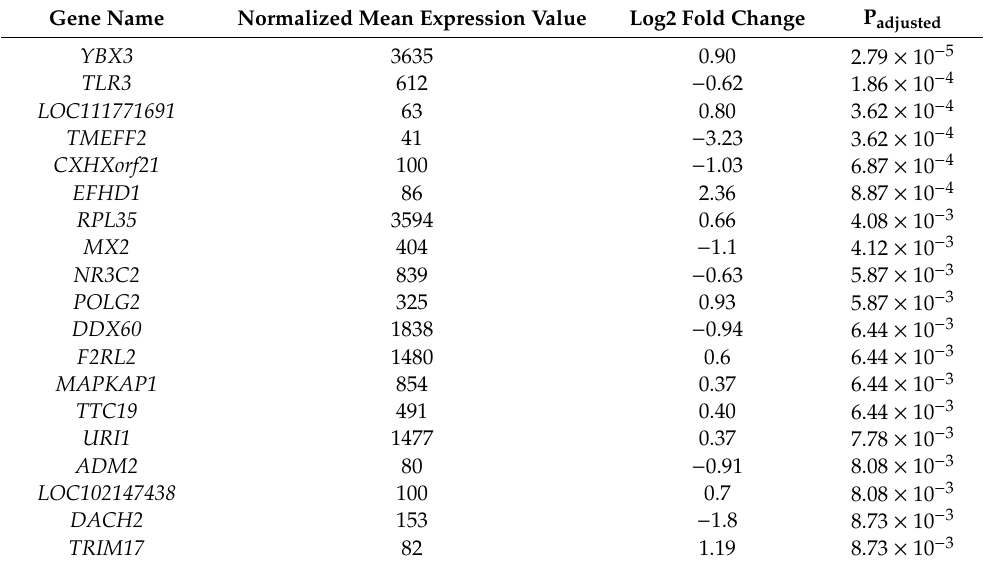
Table 9. Top 20 significantly di ff erentially expressed genes between asthmatic horses in remission and healthy horses according to the adjusted p -value. The normalized mean expression values calculated by DESeq2, the log2 fold change, as well as the adjusted p -values are listed.